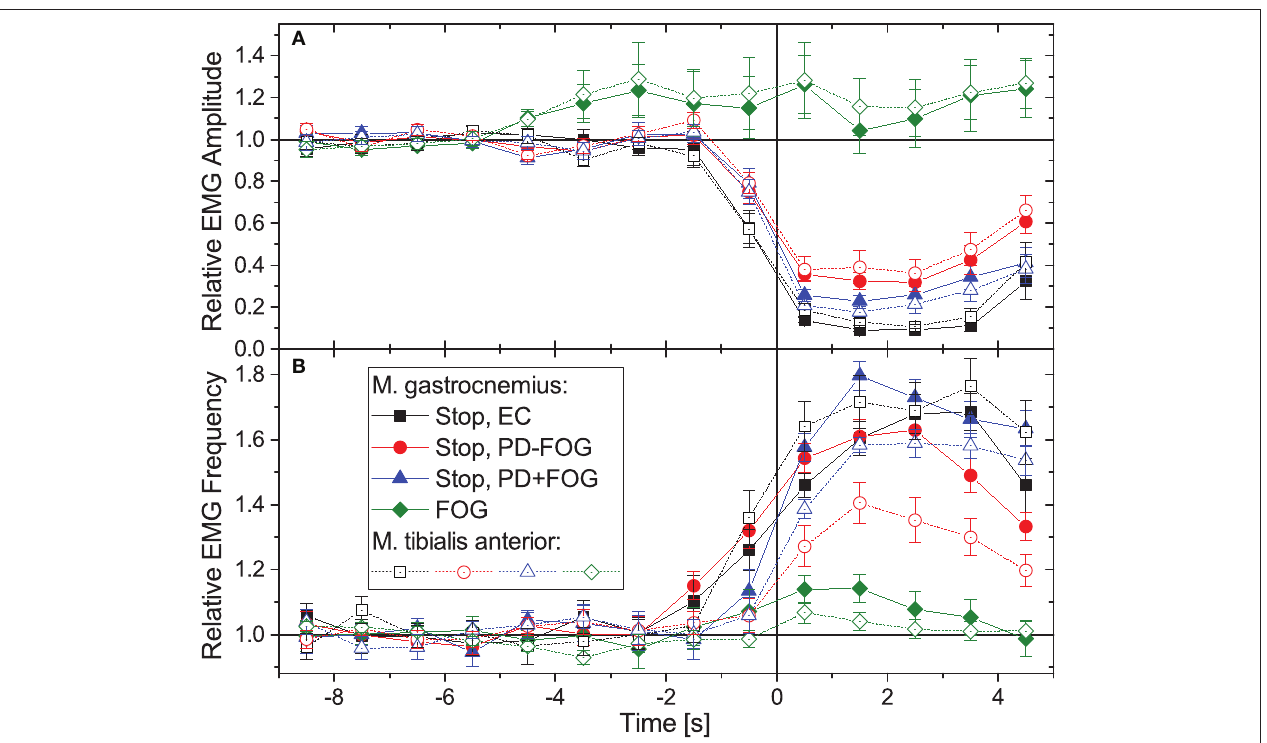
FIGURE 2 | (Color online) Relative changes of (A) EMG amplitudes and (B) EMG frequencies during gait (time: –9 to 0 s) followed by a commanded stop or a FOG event (time: 0 to +5 s). Time 0 (the vertical line) corresponds to a complete stop or FOG event (according to video footage). In case of stopping the command to stop was given 1–2 s earlier, which explains the changes starting before 0. Data have been normalized to 1 for normal walking (time from –9 to –5 s). For stops, data from the three groups show a similar behavior, i.e., significant drops in EMG amplitude and increases in EMG frequency. However, for FOG events EMG amplitudes and frequencies hardly change. Full symbols are for musculus gastrocnemius and open symbols for musculus tibialis anterior (no significant differences); data from left and right leg and all available episodes and subjects have been averaged. Error bars indicate the standard error of the mean (standard deviation divided by square root of number of stop/FOG epochs). We note that no points that appear to the left of the vertical line (time 0) are affected by data measured after time 0. This also holds vice versa, except for the normalization coming for the data measured more than 5 s before time